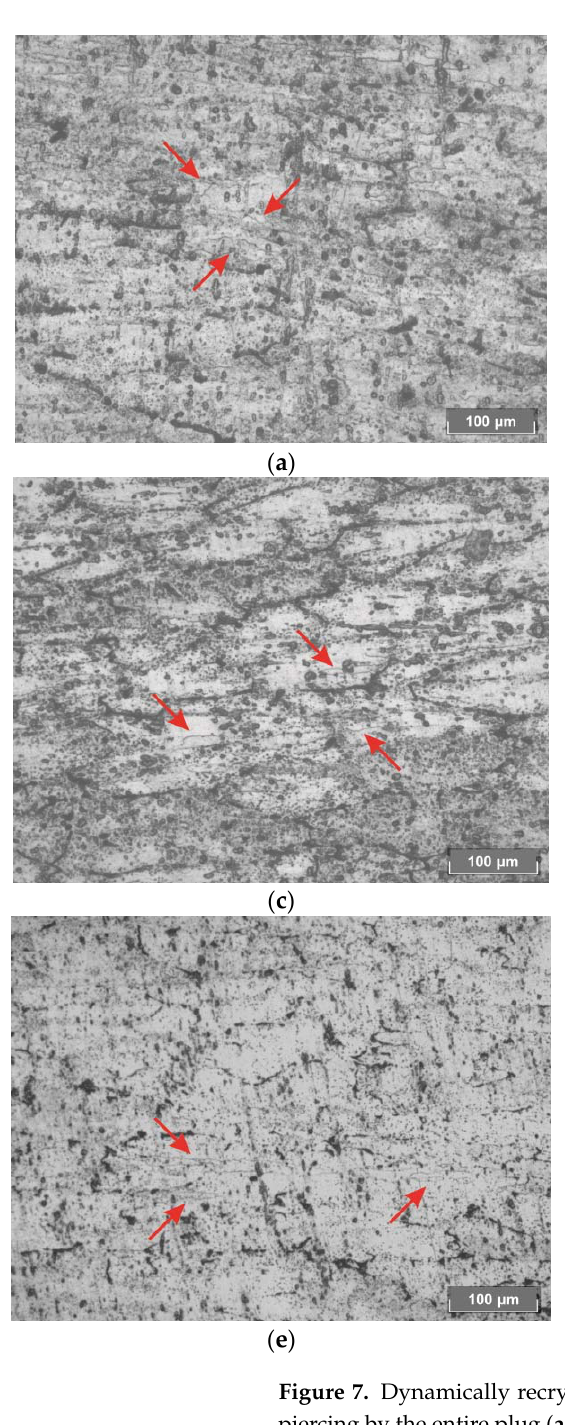
The elongated chain of dynamically recrystallized small grains, 5–10 µ m in size with rough edges, is observed near the subgrains’ boundaries (Figure 7). These chains are identified with arrows in Figure 7.